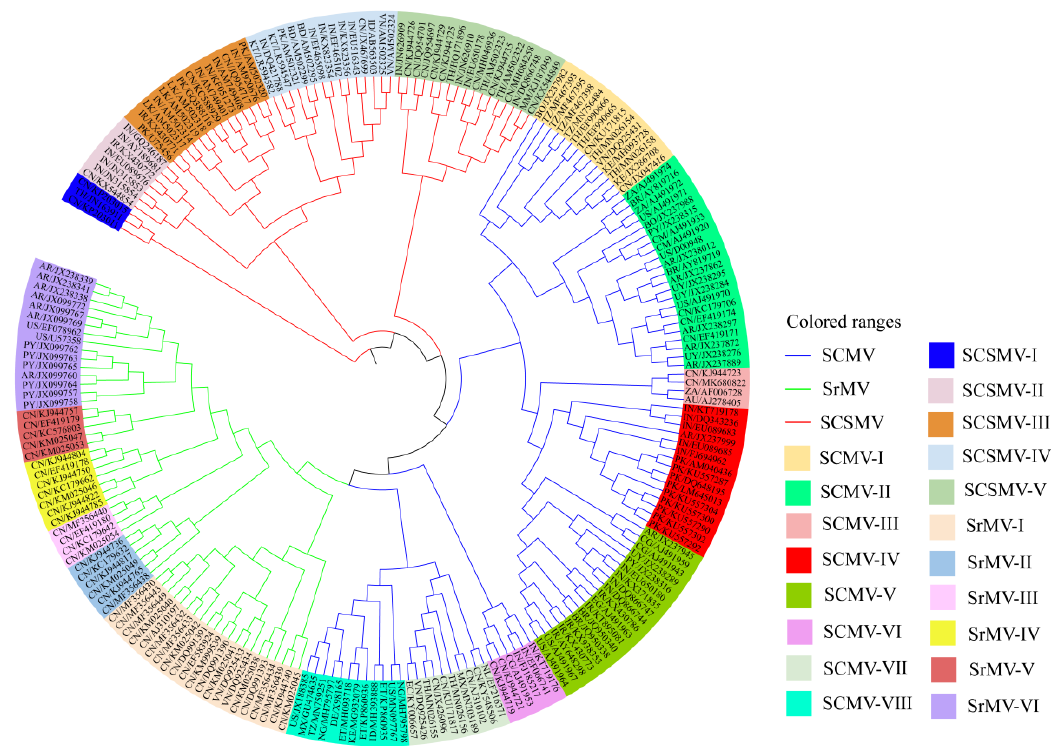
Figure 4. Genetic diversity analysis of coat protein genes of three viruses causing sugarcane mosaic disease. Note: Red line represents SCSMV, blue line represents SCMV, and green line represents SrMV. Different colour boxes represent different subgroups.